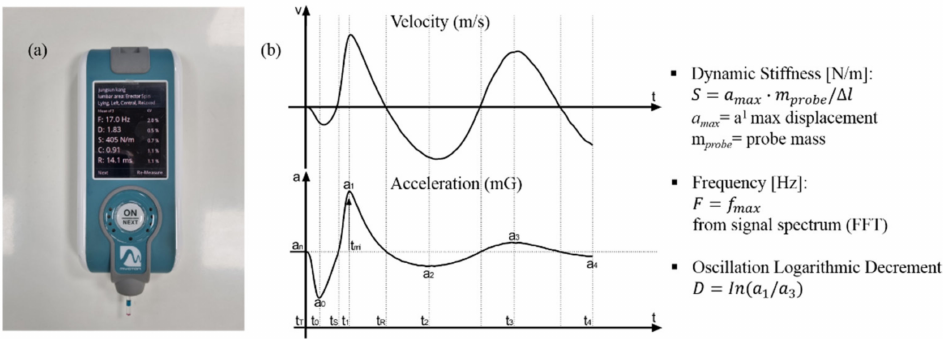
Figure 2. Myotonometer used in the experiment ( a ) and the extracted signal characteristics ( b